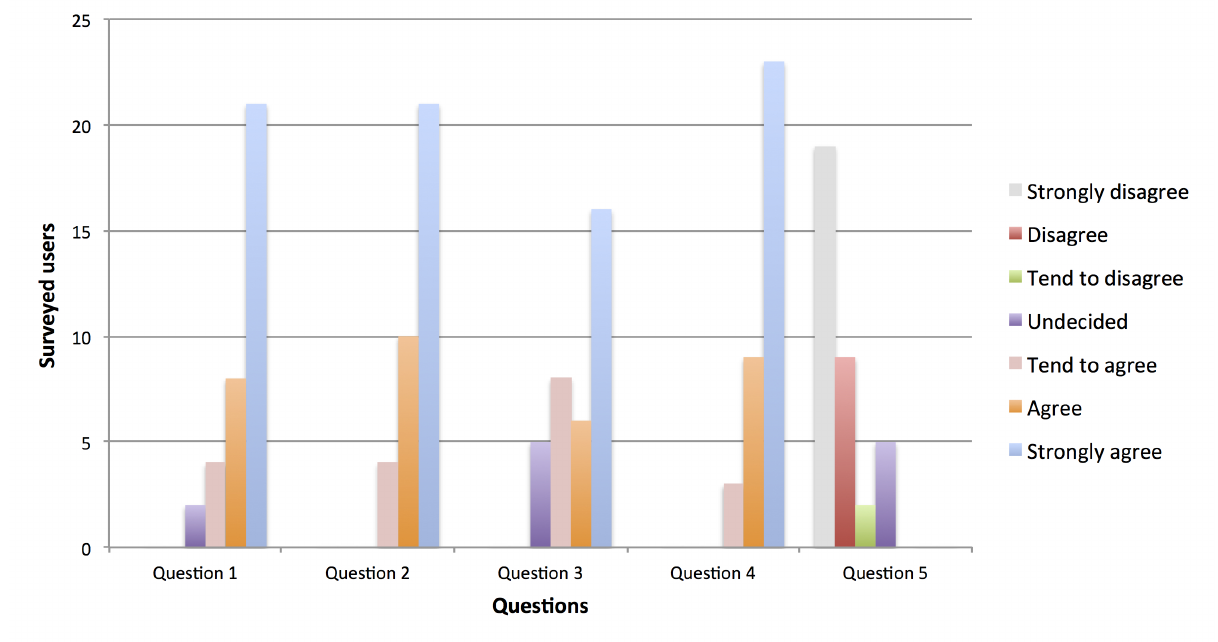
Figure 4. Results of the survey evaluating the main questions about the performance of the mHealth app with the proposed cooperation strategy and encryption solution.